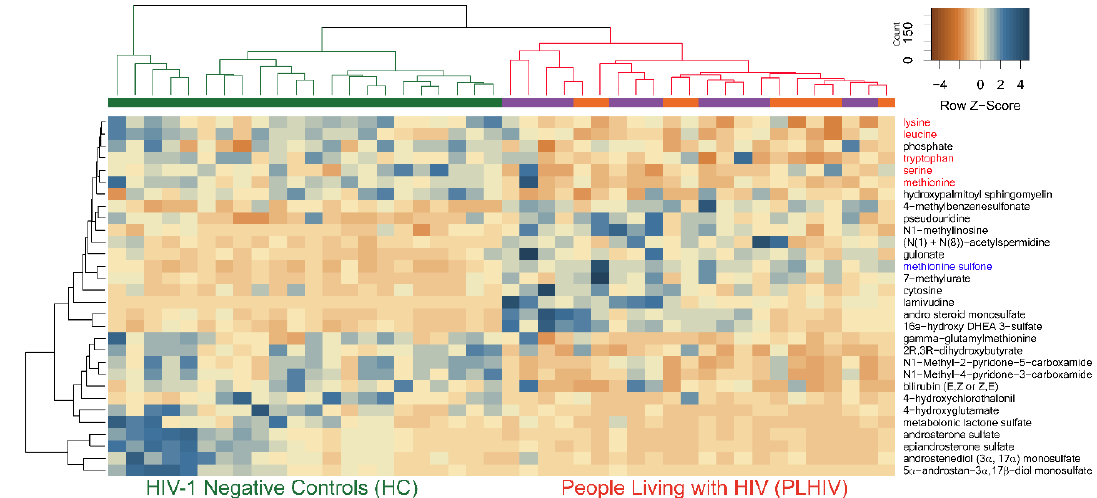
Figure 6. The hierarchical clustering of all the samples (HC and PLHIV) indicated negative z -scores for lysine, leucine, methionine tryptophan, and serine (marked in red), indicating lower levels in PLHIV compared to HC; however, methionine sulfone (marked in blue) had a higher level with positive z -scores in PLHIV.